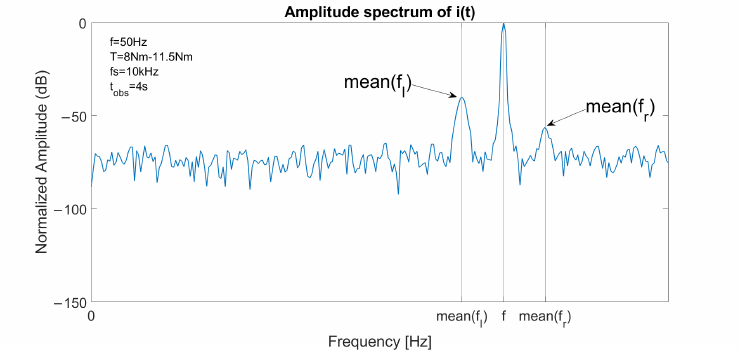
Figure 7. Spectrum of a stator current in case of one broken bar and linear ramp of requested torque from 8 Nm to 11.5 Nm (increasing slip). Fundamental component is located at f , left sideband component is located at the mean value of f l = ( 1 − 2 s ) · f and right sideband component is located at the mean value of f r = ( 1 + 2 s ) · f .